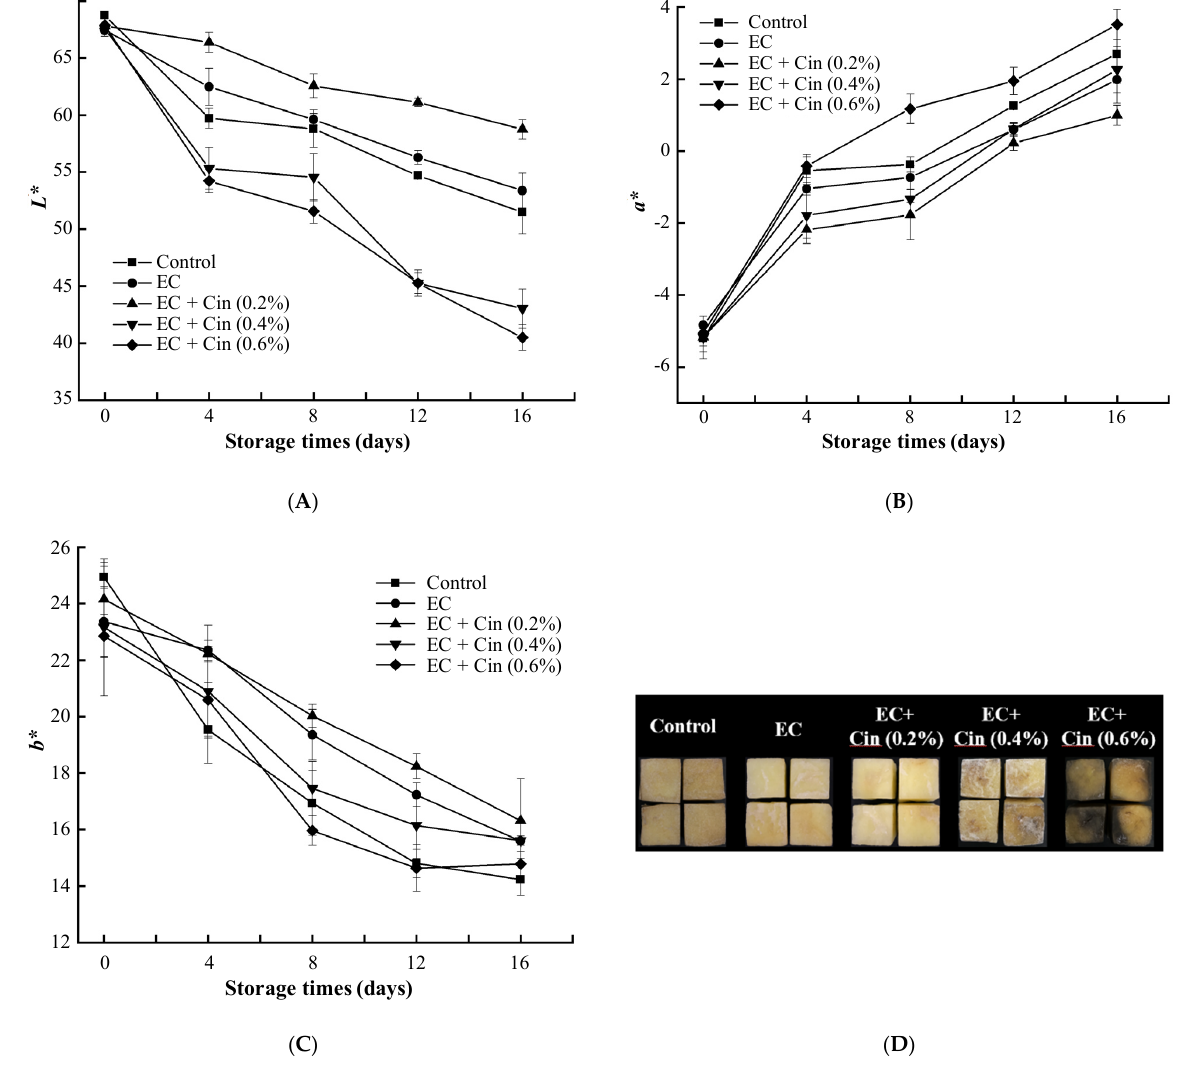
Figure 2. Changes in colour of fresh-cut potatoes coated with chitosan-based EC containing cinnamon oil. ( A ) L* ; ( B ) a* ; ( C ) b* ; ( D ) appearance on the 16th day. Control: uncoated; EC: edible coating; Cin: cinnamon oil. Bars represent means ± SD ( n = 3, p < 0.05).